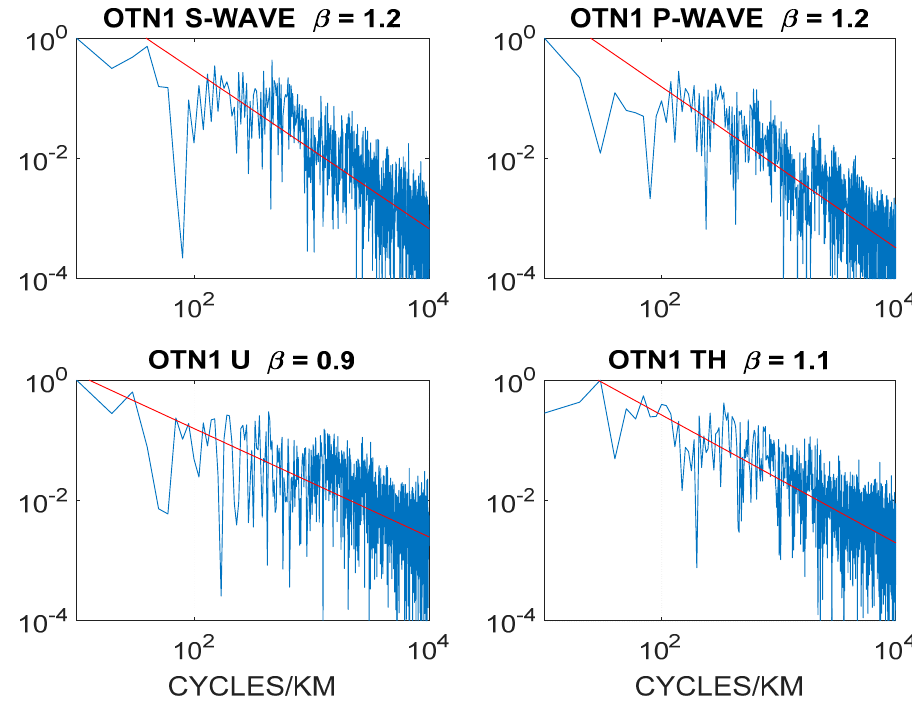
Figure 22. Sample OTN1 well-log spectral scaling S(k) ~ k β , β ~ 1.2 ± 0.1; depth 1000–1800 m. Energies 2017 , 10 , 1979